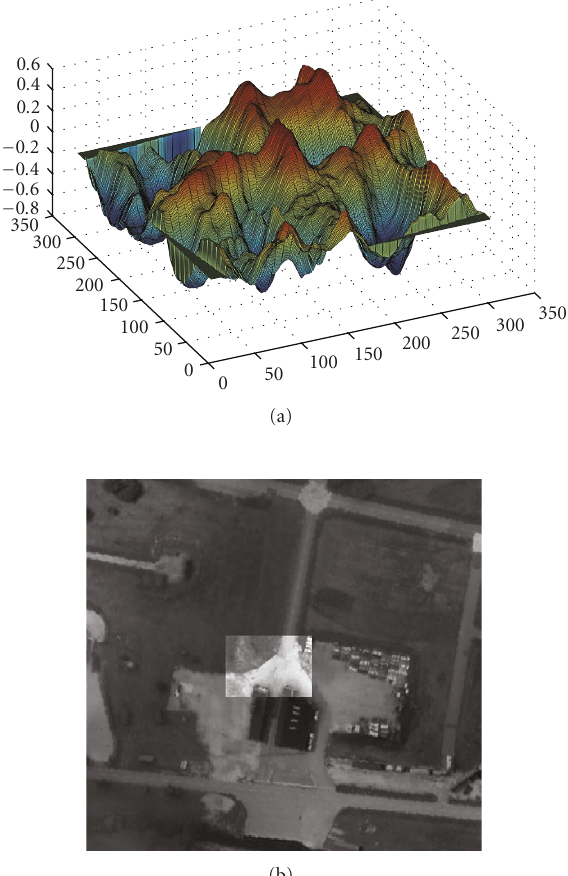
Figure 4: (a) depicts the normalized cross-correlation results, and (b) depicts the sensed image matched to the reference image.